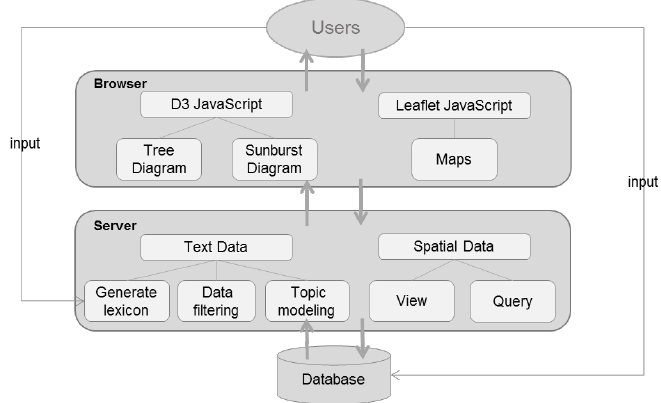
Figure 4. System design of TFA toolkit.